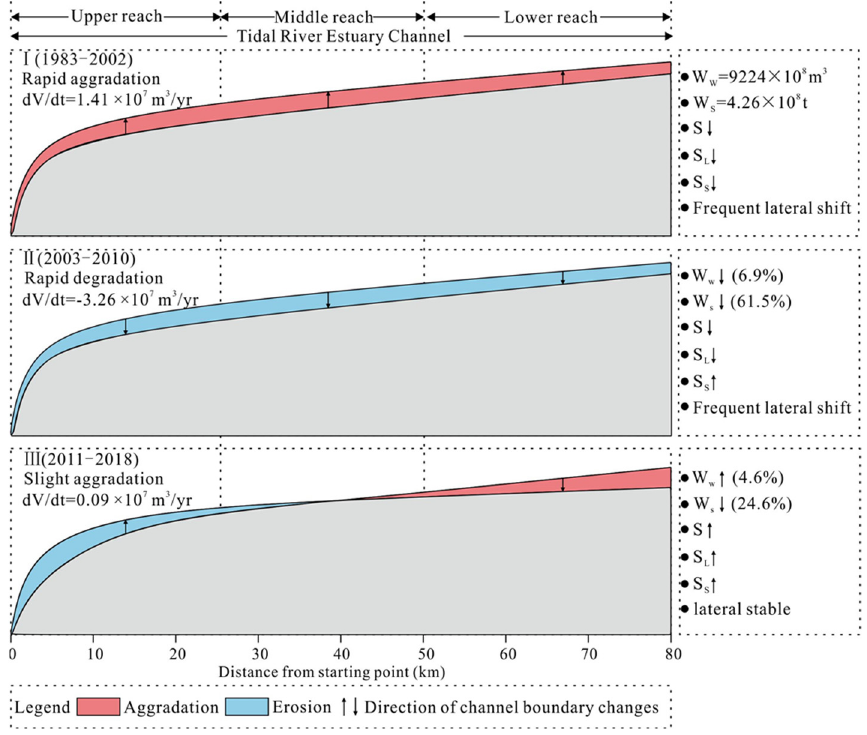
Figure 12. A conceptual model for the morphological adjustment of the SCSP. Note dV/dt = channel volume change rate. Positive values mean deposition and negative values mean erosion. Ww and WS = average annual discharge at Datong station and average annual sediment load at Datong station. S = channel slope, SL = landward slope, SS = seaward slope. ↑ and ↓ denote the increase and decrease of a geometric parameter,